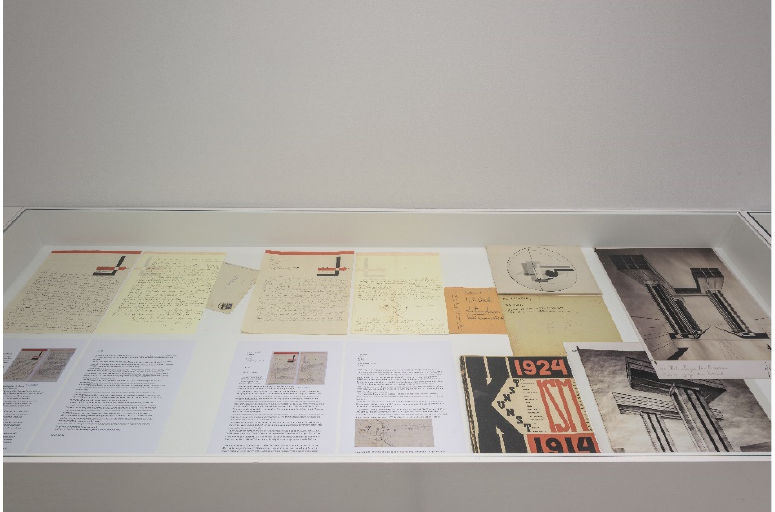
Figure 35. View of one of the vitrines in the exhibition ‘100 Years De Stijl: Lissitzky and Oud in dialogue’, Van Abbemuseum, 2017.